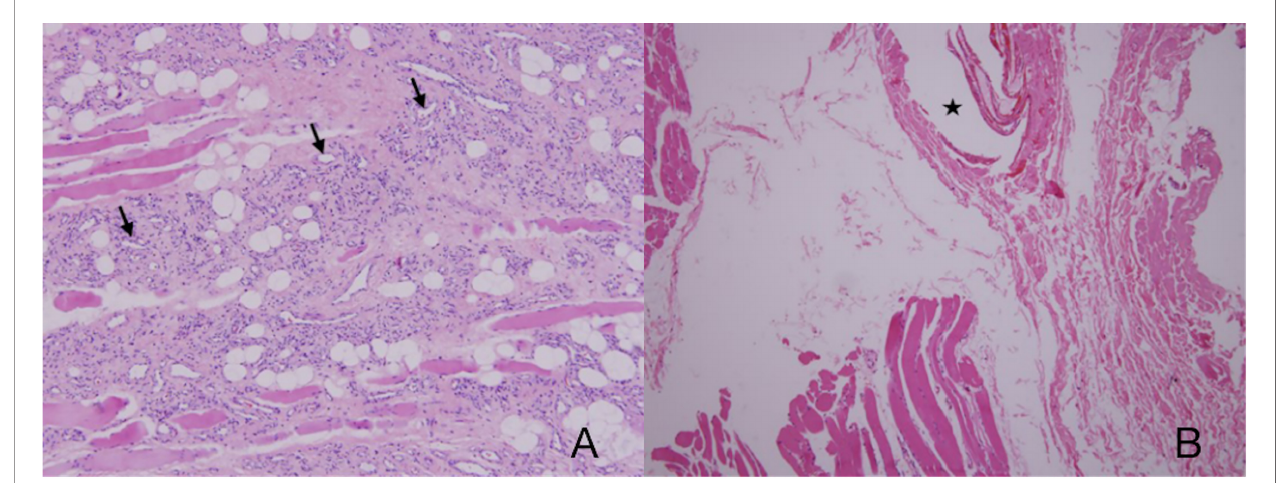
FIGURE 1 | (A) Capillary-type IMHs: diameter <140 m m (arrows). (B) Cavernous-type IMHs: blood vessel diameter >140 m m (star). Hematoxylin and eosin (H&E) staining. Original magni fi cations,